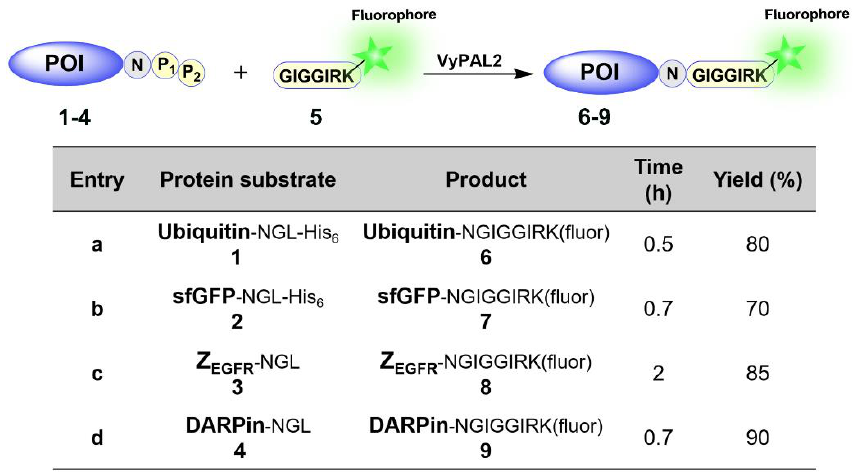
Figure 1. VyPAL2-mediated protein C-terminal labeling with a fluorescent peptide. See Supporting Information for detailed experimental conditions, procedures, and analytical data. All yields reported in this study are conversion yields based on HPLC analysis.